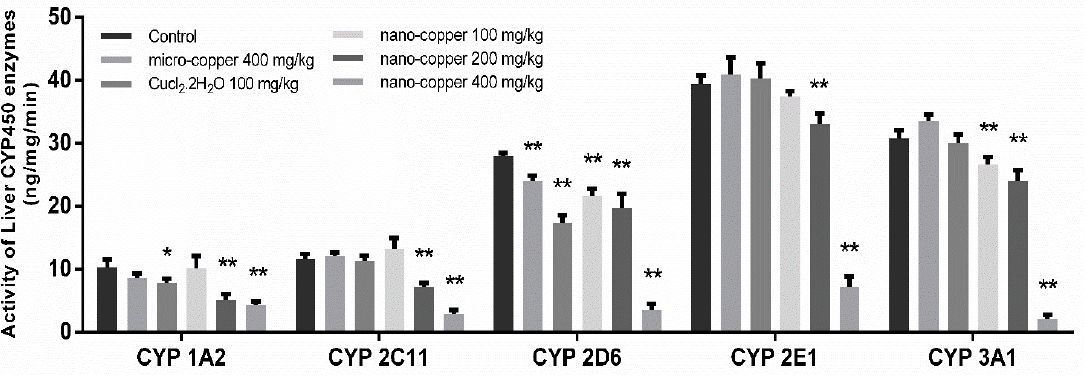
Figure 8. The activity of CYP450 enzymes. * p < 0.05, ** p < 0.01 vs. control group. The activity of CYP450 is inhibited by nano-copper in a dose-dependent manner.